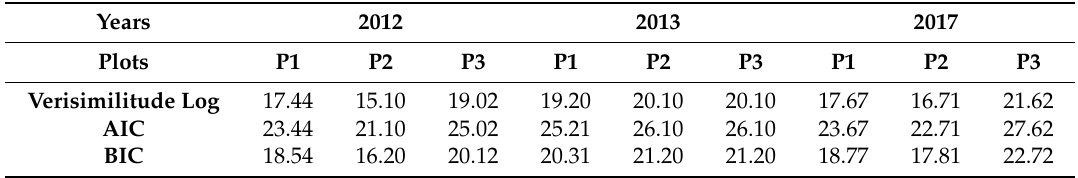
Table A5. Verisimilitude log values and Akaike (AIC) and Bayesian (BIC) information criteria obtained in the Generalized Lineal Mixed Model (GLMM)